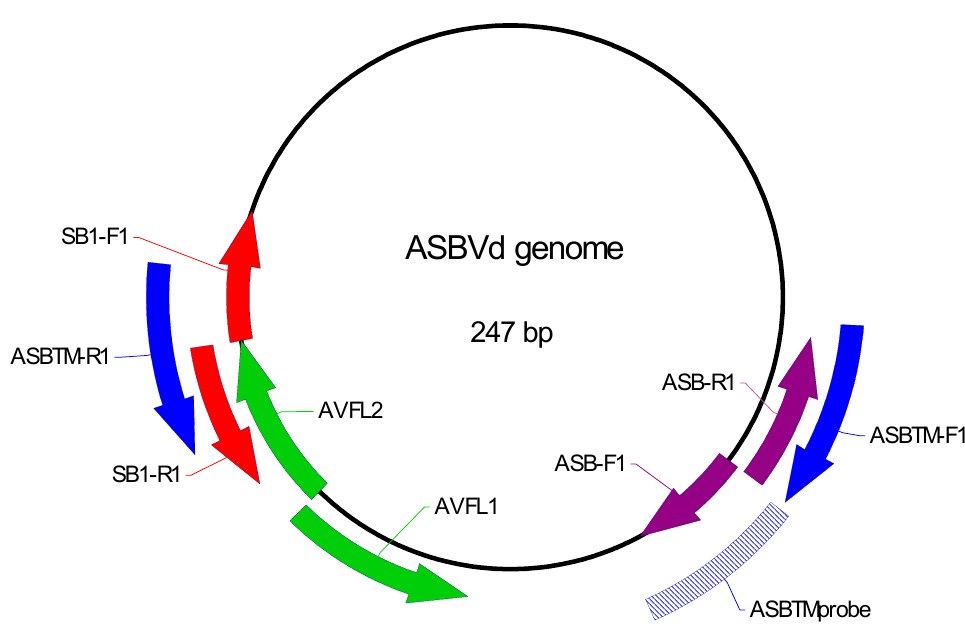
Figure 1. Primers tested for assay design. Primer locations on the ASBVd genome, including primer sequences, are listed in Table 2.